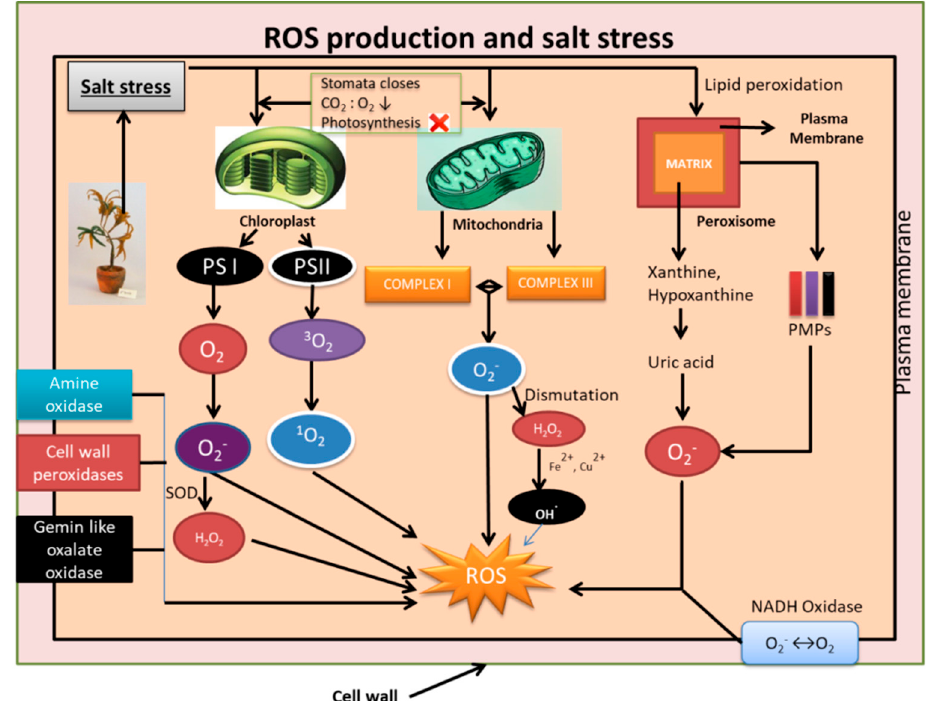
Figure 1. Schematic representation of mechanisms involved in generation of reactive oxygen species (ROS) during salinity stress. Organelles such as chloroplast, mitochondria, and peroxisome are involved in the generation of free radicals such as O 2 − , singlet oxygen ( 1 O 2 ), OH . , H 2 O 2 . Apart from this, plasma membrane NADH oxidase, Amine oxidase, cell wall peroxidases, and Gemin-like oxalate oxidases also generate ROS. The generation of ROS is detrimental to cell structures, macro molecules such as DNA, lipids, proteins, and genes affecting the overall functioning of the cell.